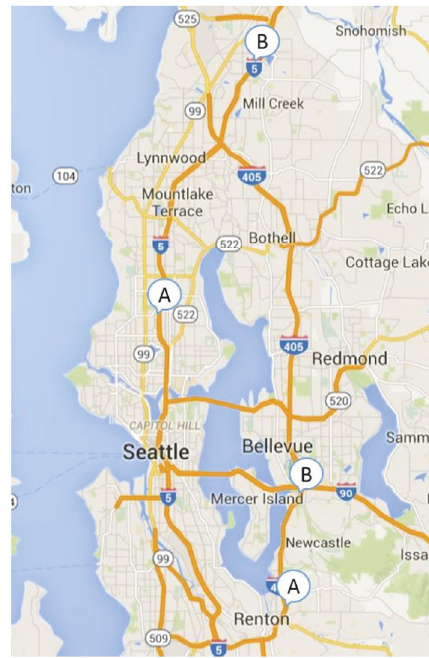
Figure 1: Locations of I-5 (Top) and I-405 (Bottom)